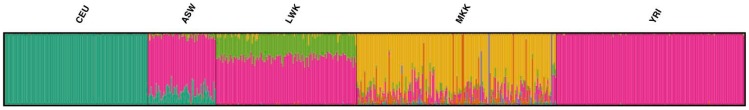
Population structure components for individuals from CEU, ASW, LWK, MKK and YRI.Results from STRUCTURE version 2.3 on genotype data for 12,999 randomly selected SNPs in 578 founder (unrelated) individuals from the CEU, ASW, LWK, MKK and YRI HapMap populations. The no-admixture model showed that the data was best fit by 6 inferred ancestral populations. Each column represents an individual, and the colors indicate the fractions of their genotype attributable to ancestry from each of the 6 ancestral populations.